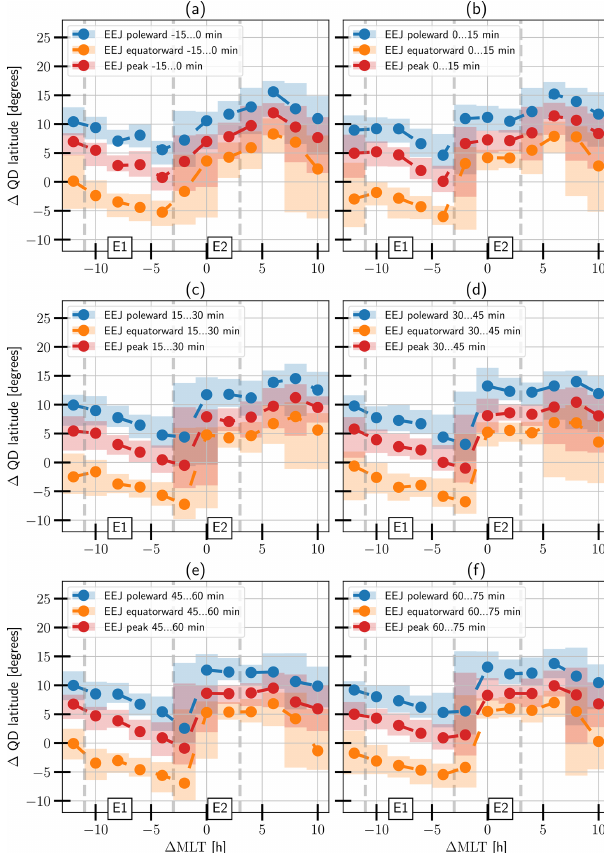
Figure 7. The evolution of the WEJ peak location and extent for the time period from 15min before to 75min after the onset. (cid:49) QD is the latitude relative to the onset latitude. The lines show the median, and the shading shows the range covered by the second and third quartiles.